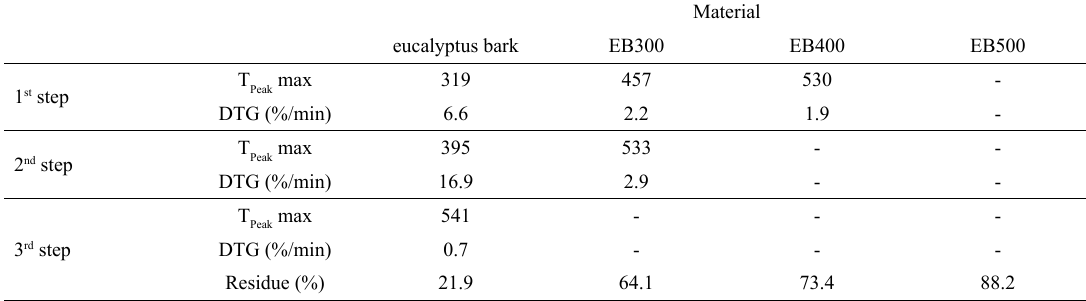
Table 2. Data obtained from the TG/DTG curves for the produced eucalyptus bark and charcoals